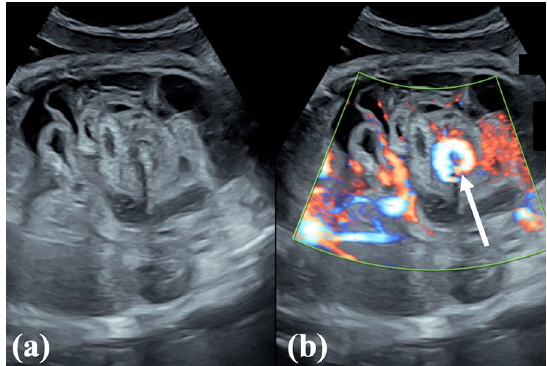
Fig. 1 Fetal ultrasound: a fetal bowel is dilated with some ascites. b Vessels of the bowel are twisted (whirlpool sign, arrow)